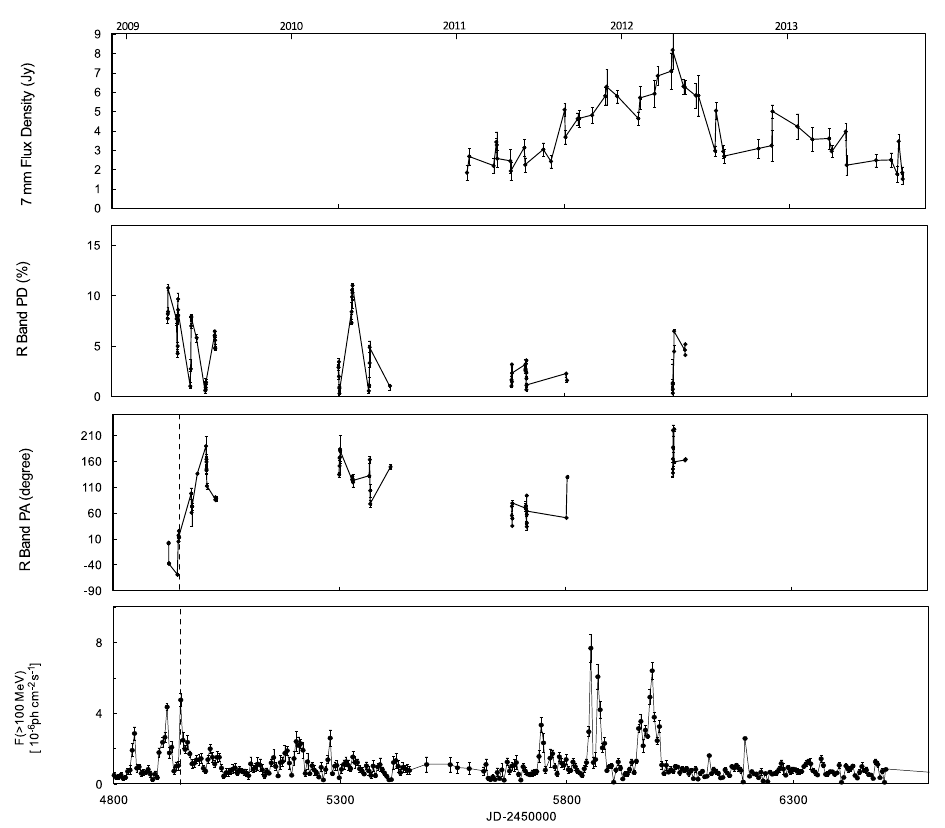
Figure 1. Top : 7 mm emission observed with the Itapetinga Radio Observatory (ROI). Middle : Polarization degree at R -band obtained at Picos dos Dias Observatory (OPD). Bottom : Idem for the polarization angle. The vertical dashed line indicates the moment that polarization angle ( PA ) rotated by almost 70 o in a two-day